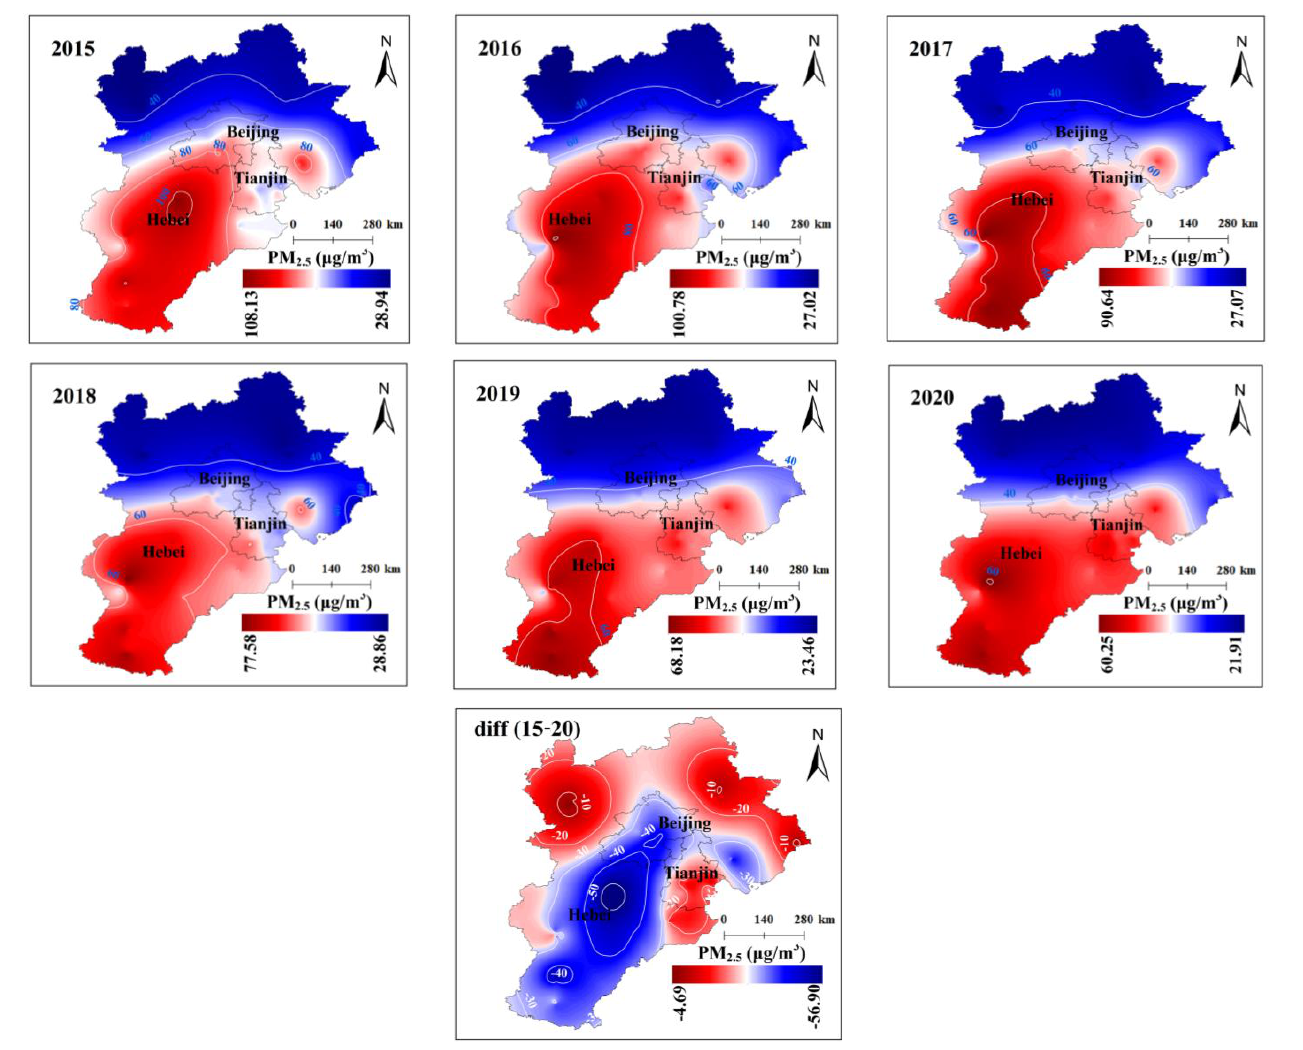
Figure 3. Annual spatial change of PM 2.5 in the BTH.